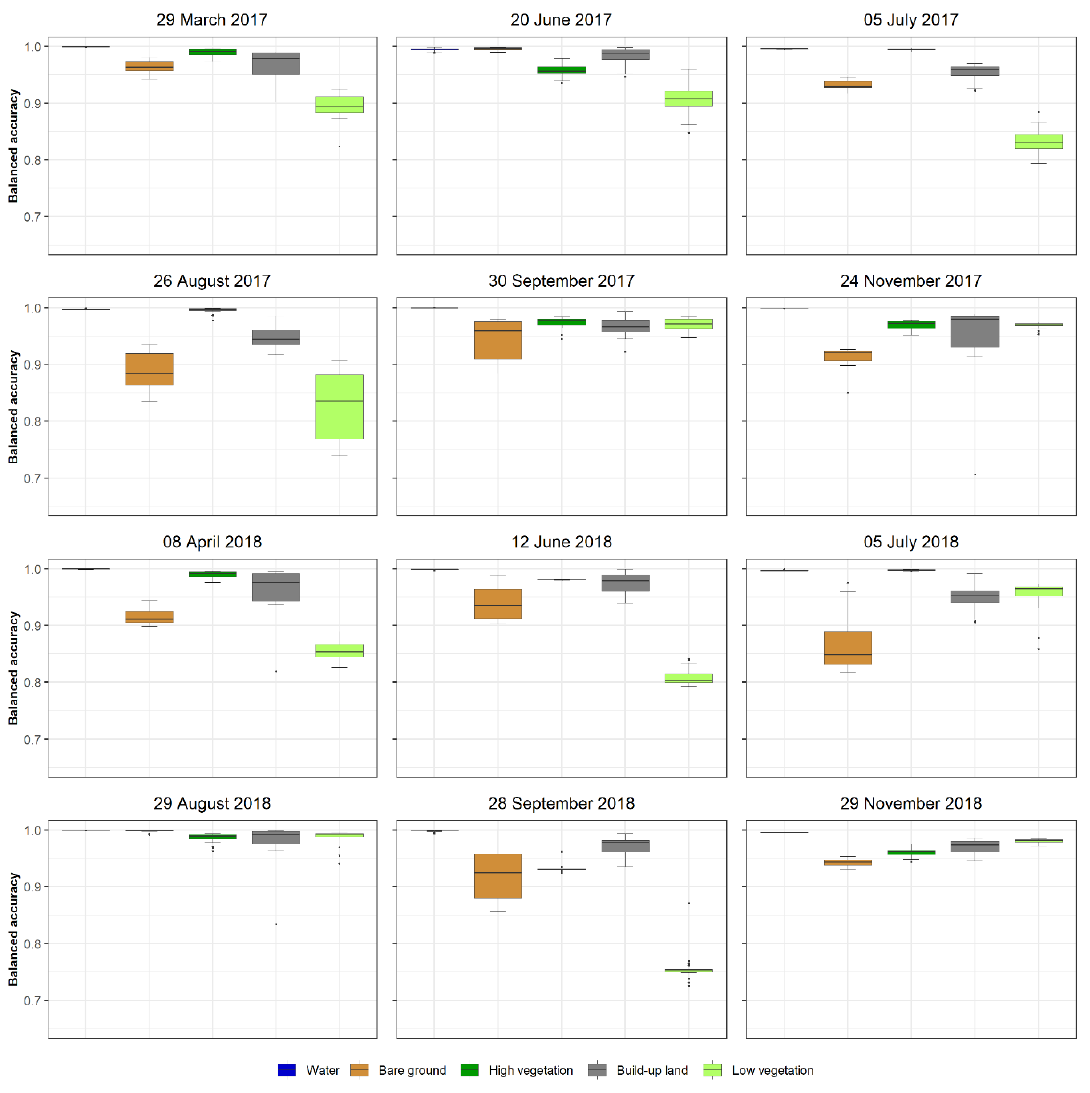
Figure 7. Box-plot of balanced classification accuracies of land cover classes without radiometric indices for combined atmospheric corrections for twelve